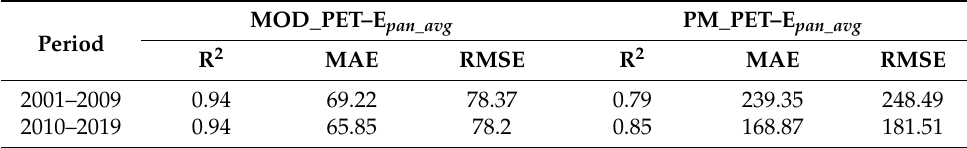
Table 1. Parameters of quantitative evaluation based on the correlation analyses.